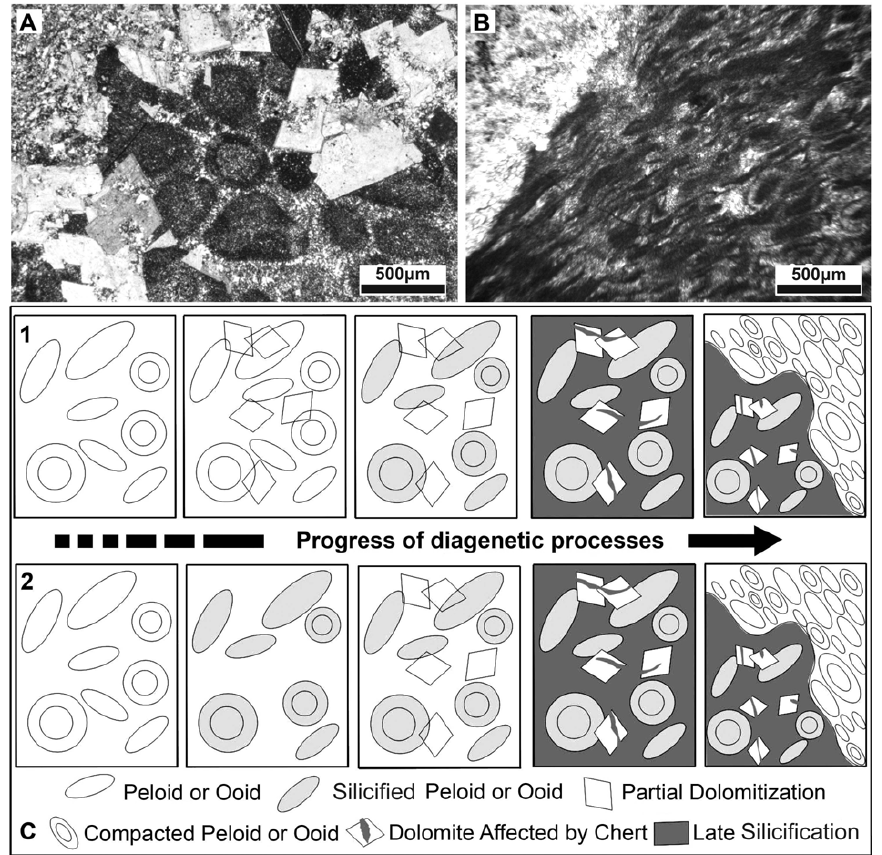
Fig. 5 – Chert and compactation. A – Thin section showing carbonate grains (peloids, ooides) totally silicified, associated with dolomite rhombs. Plane-polarized light. B – Same thin section of A, another sector, highly compacted carbonate grains in contact with chert nodule. C – Schematic models of the diagenetic evolution: 1 – Formation of early dolomite followed by an early selective silicification of the carbonate grains; another pulse of chert that constitutes the cement begins to affect partially the dolomite crystals. Intense compactation of non silicified components. 2 – Early silicification of the carbonate grains, partial dolomitization; later silicification that constitutes the cement and affects the dolomite. Intense compactation of non silicified